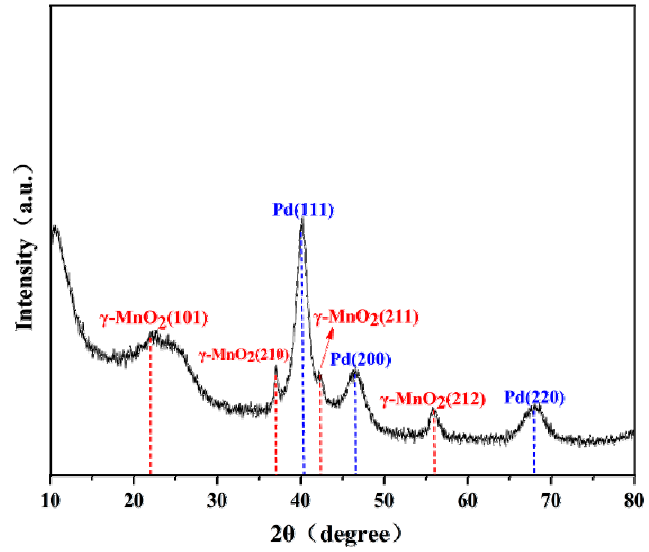
Figure 4. XRD pattern of Pd/ γ -MnO 2 catalyst.